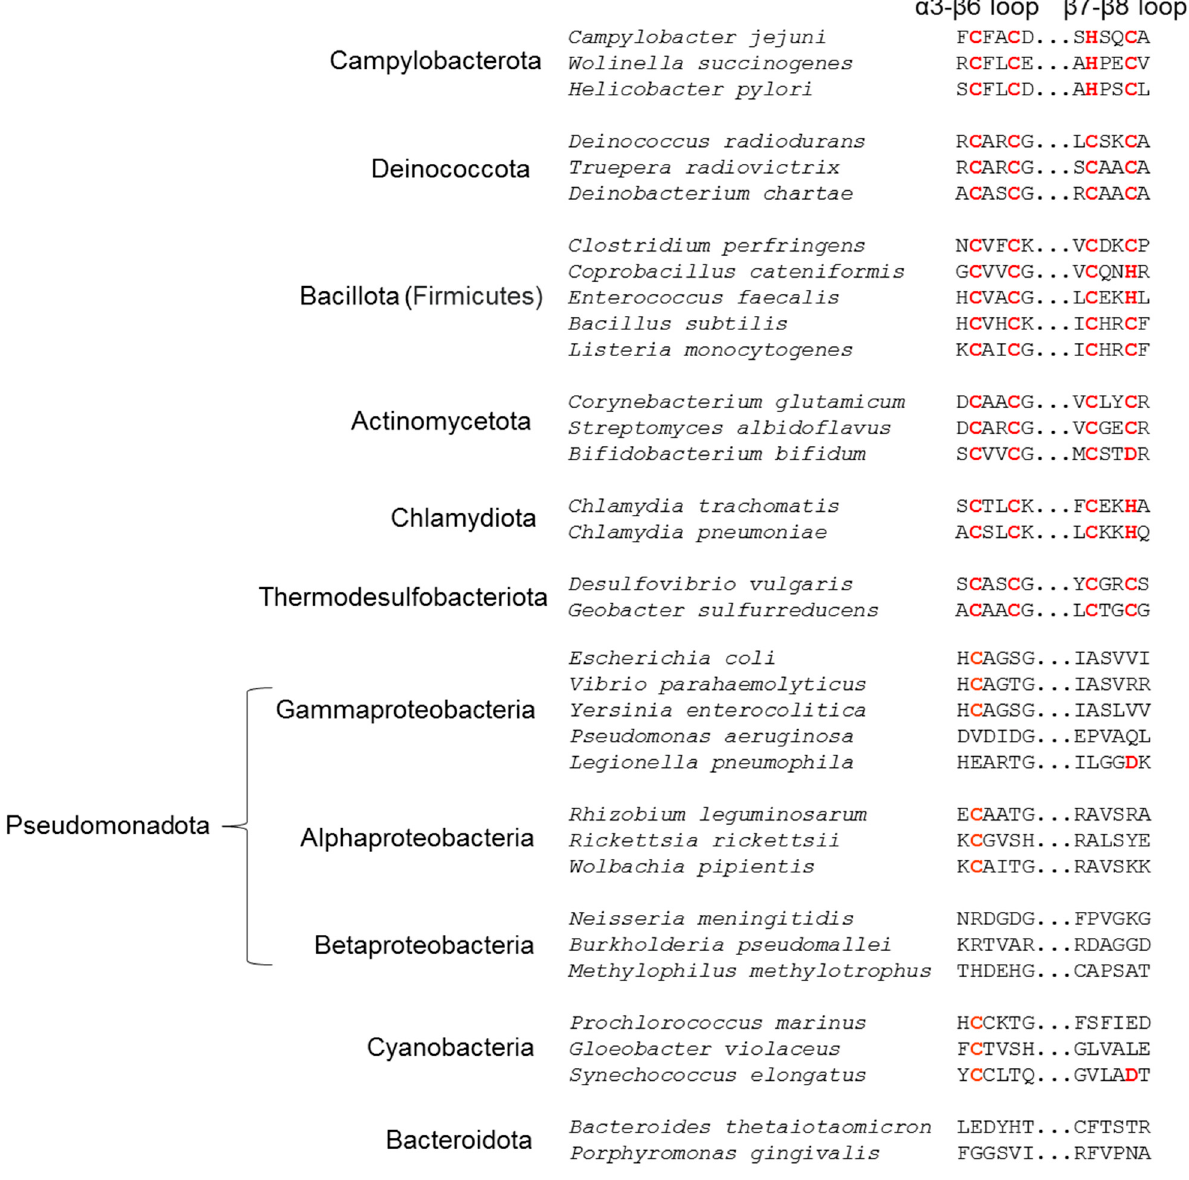
Figure 4. The sequence of RecO proteins from diverse taxa at the Zn 2+ -binding motif represented by the CxxC . . . C/HxxC/H/D sequence. The conserved residues at the Zn 2+ -binding motif and their equivalent identical sequences are colored red.